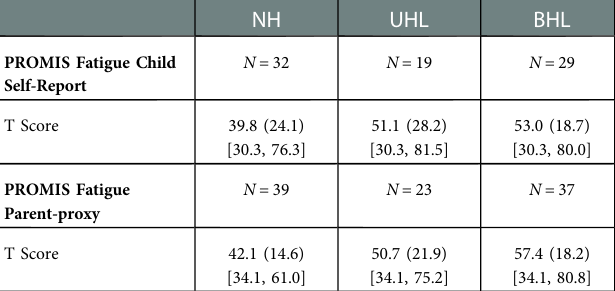
TABLE 4 Medians (interquartile range) and [min, max] of child self-report and parent-proxy report from the PROMIS fatigue short form. NH UHL